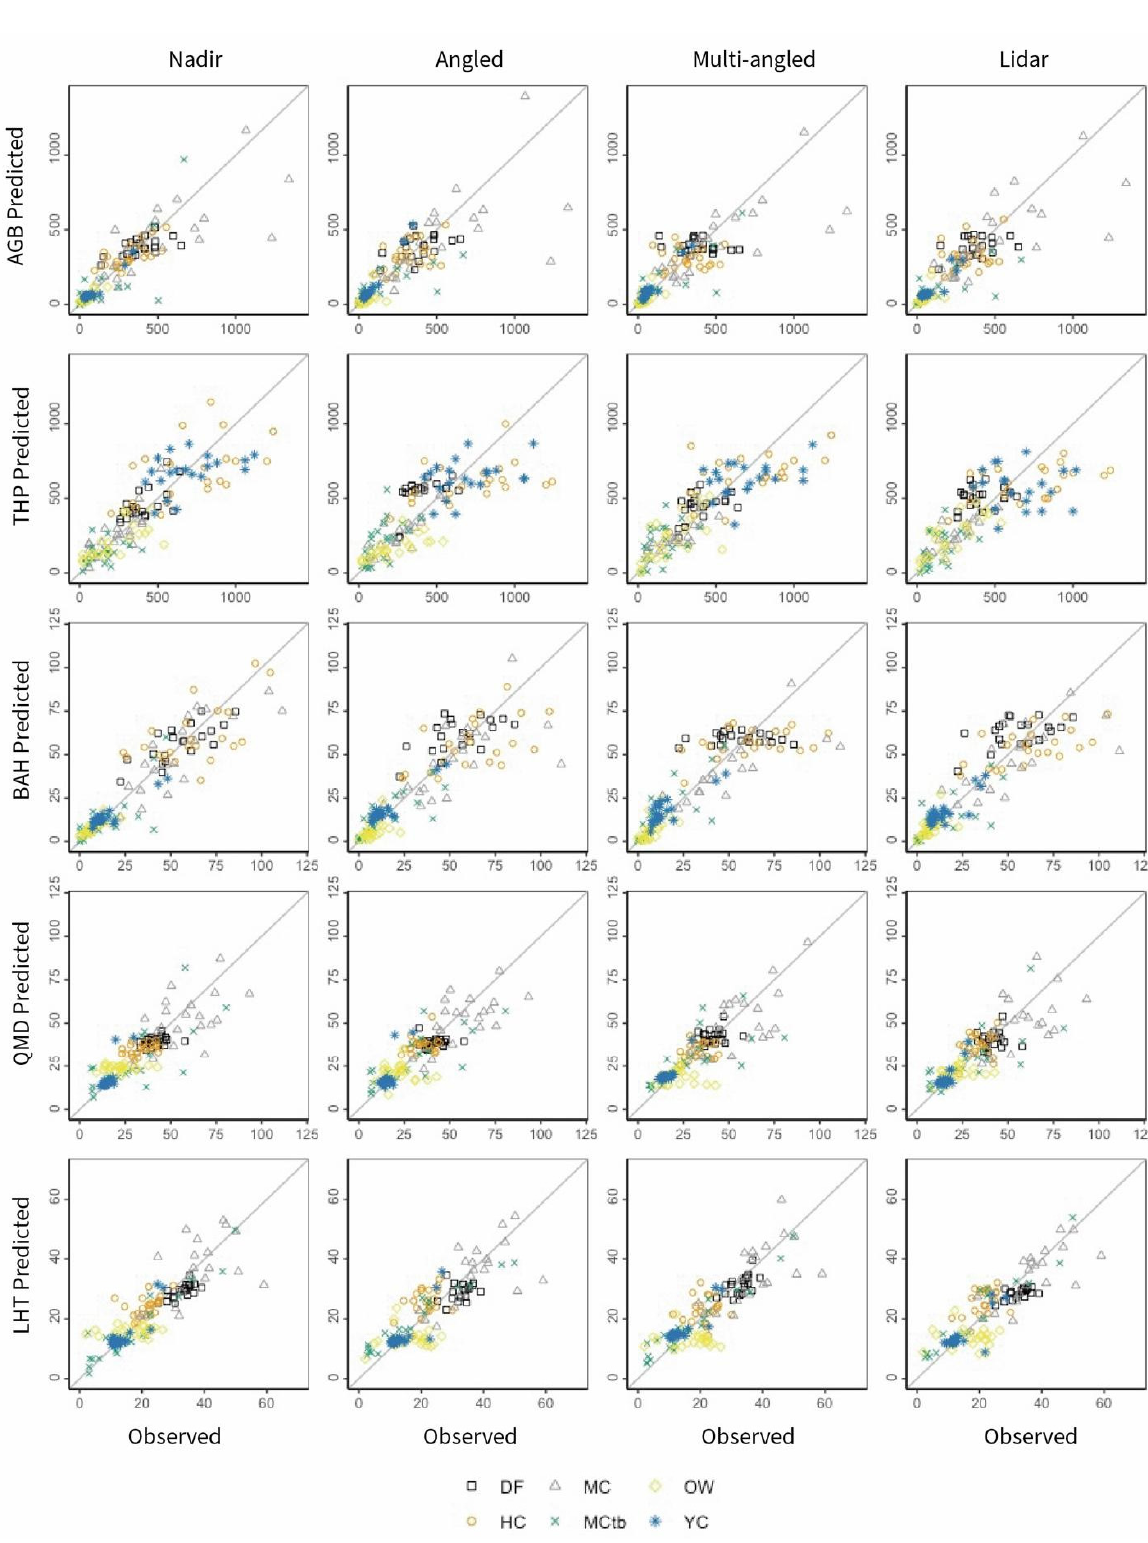
Figure 6. Observed vs. predicted plot-level estimates of AGB, TPH, BAH, QMD, and LHT. Solid line displayed is the 1:1 line. Plots color coded by site.